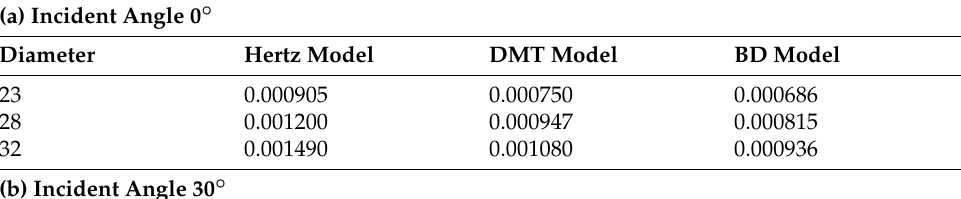
Table 3. The critical damping coefficients of Hertz model, DMT model, and BD model at different incident angles.